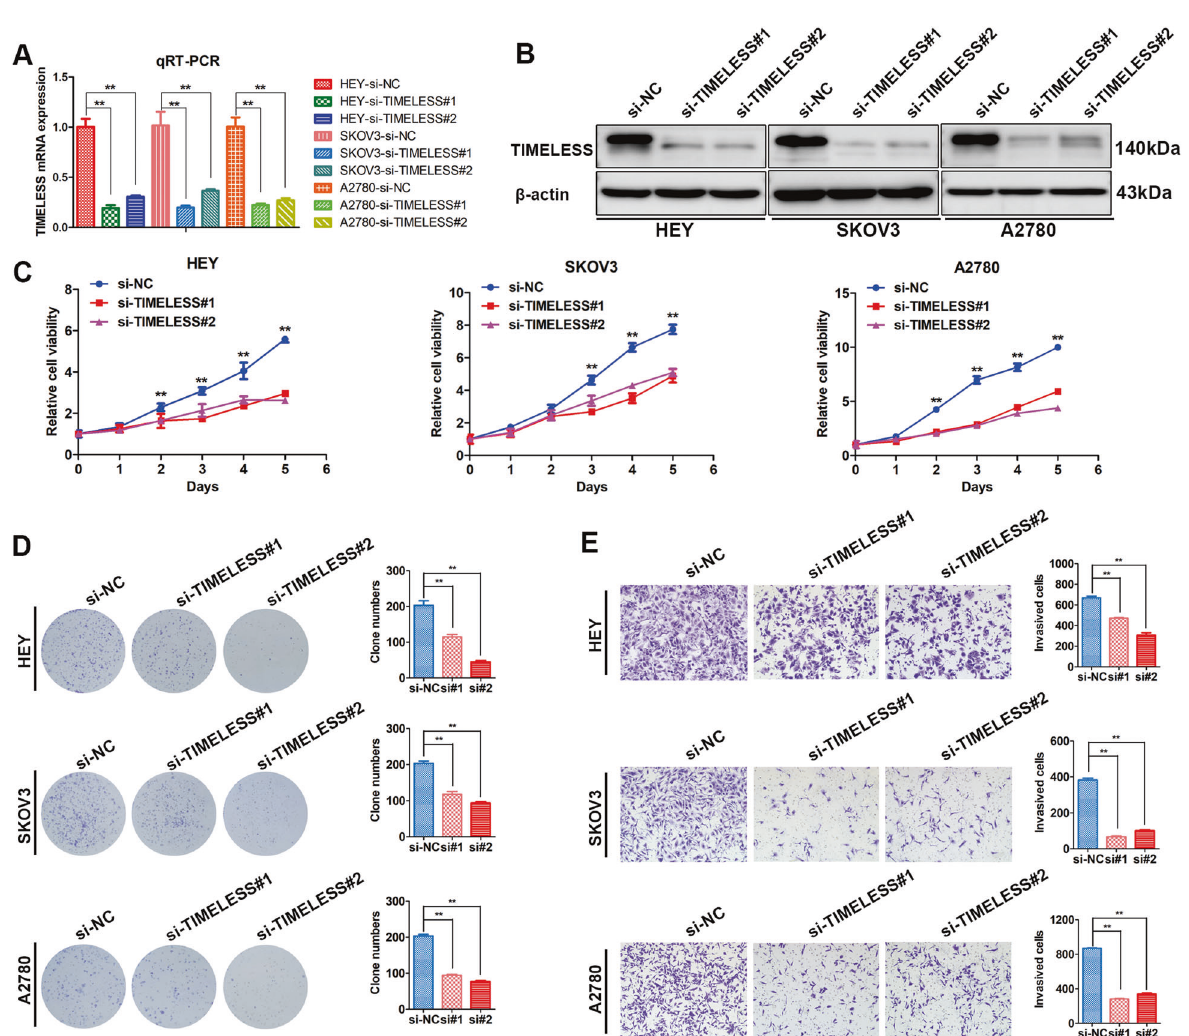
Fig. 5 TIMELESS mediates the growth and metastasis of ovarian cancer cells. A , B TIMELESS knockdown ef fi ciency was con fi rmed by qRT- PCR ( n = 4 biologically independent samples) and western blotting. C Growth curves and D clonogenic assays were used to evaluate the effect of TIMELESS knockdown on the proliferation of ovarian cancer cells ( n = 5 biologically independent samples). E Transwell assays showed the invasion capacity of ovarian cancer cells upon TIMELESS knockdown ( n = 5 biologically independent samples). P -value was obtained by unpaired t -test. Results represent the mean ± SD of three independent experiments. * P < 0.05, ** P < transcript TIMELESS-201/203 expression was decreased and CCLE database (Fig. 7E). TIMELESS-201 and TIMELSS-203 were unspliced transcript TIMELESS-205 expression was increased overexpressed in ovarian cancer, and there was no difference in (Fig. 7H). The proportion of unspliced transcript expression TIMELSS-205 expression between ovarian cancer and normal compared with spliced transcript expression was obviously control tissues (Fig. 7F). TIMELESS-205 expression was related to increased after MEX3A knockdown (Fig. 7I). Speci fi c primers better prognosis in ovarian cancer (Fig. 7G). RT-PCR was applied within intron 23 were also used to validate TIMELESS relative to determine the relative expression of TIMELESS transcripts expression after MEX3A knockdown through qRT-PCR, and the using primers that span intron 23 after MEX3A knockdown in results were in accordance with the RT-PCR results (Fig. 7J). ovarian cancer cells, and the results showed that spliced